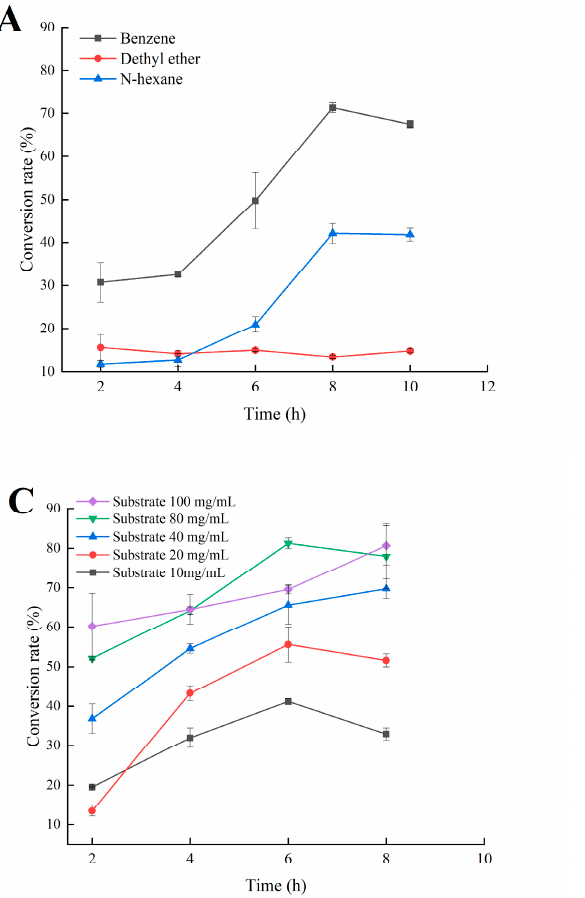
Figure 6. Effect of various organic solvents ( A ), benzene to aqueous phase ratio ( B ), substrate concentration ( C ), and enzyme amount ( D ) on the conversion rate of PA by using soy-PC as substrate.